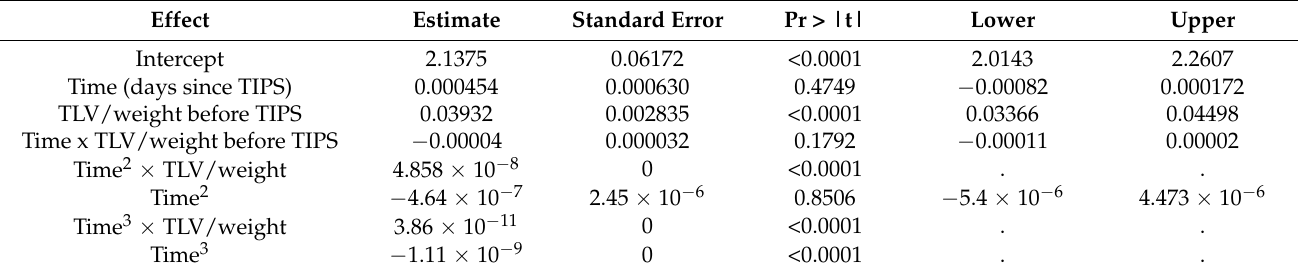
Table 6. Regression coefficients for the explorative model for TLV/weight ratio and time.